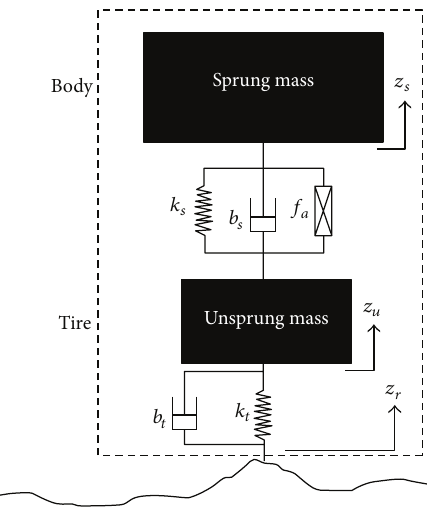
Figure 1: A quarter-car model of suspension